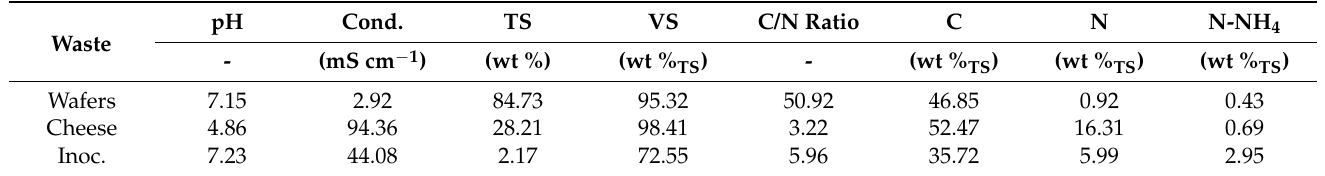
Table 2. Physicochemical parameters of feedstock and